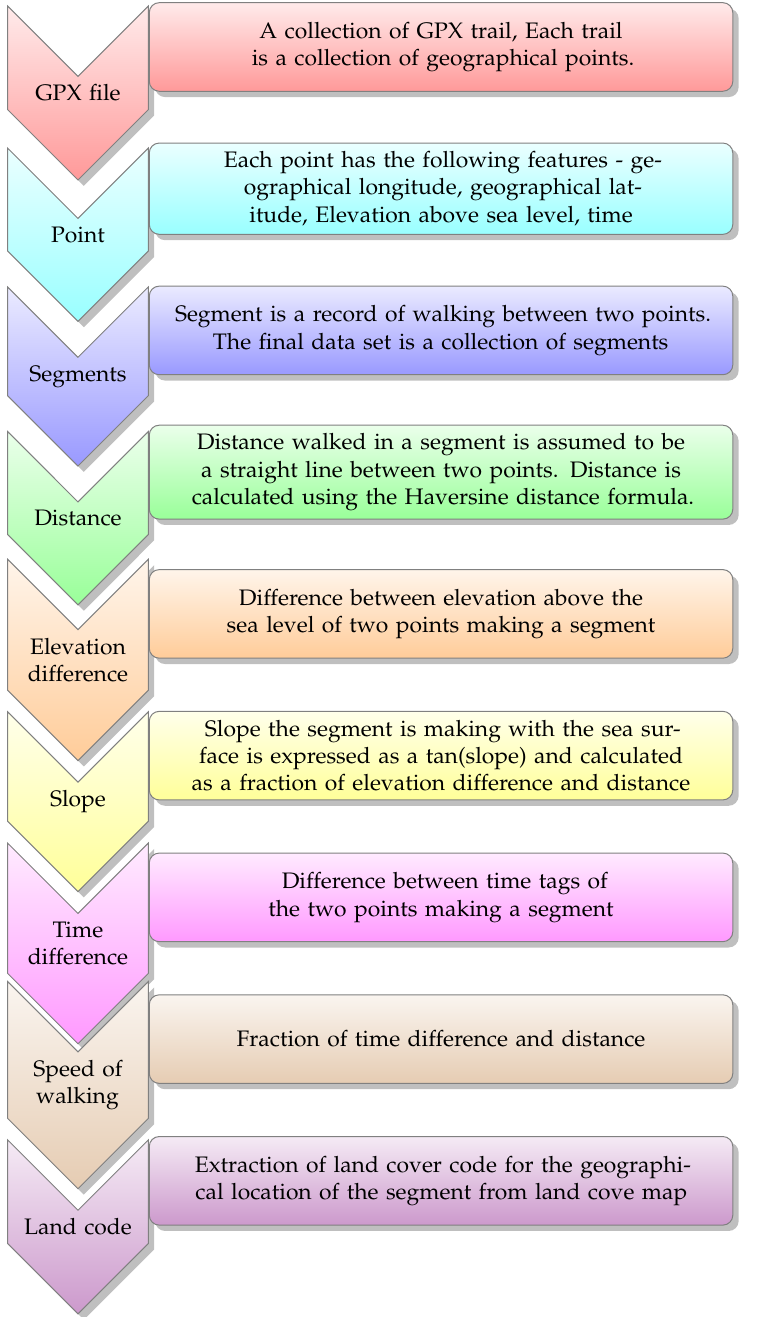
Figure 1. Steps of data